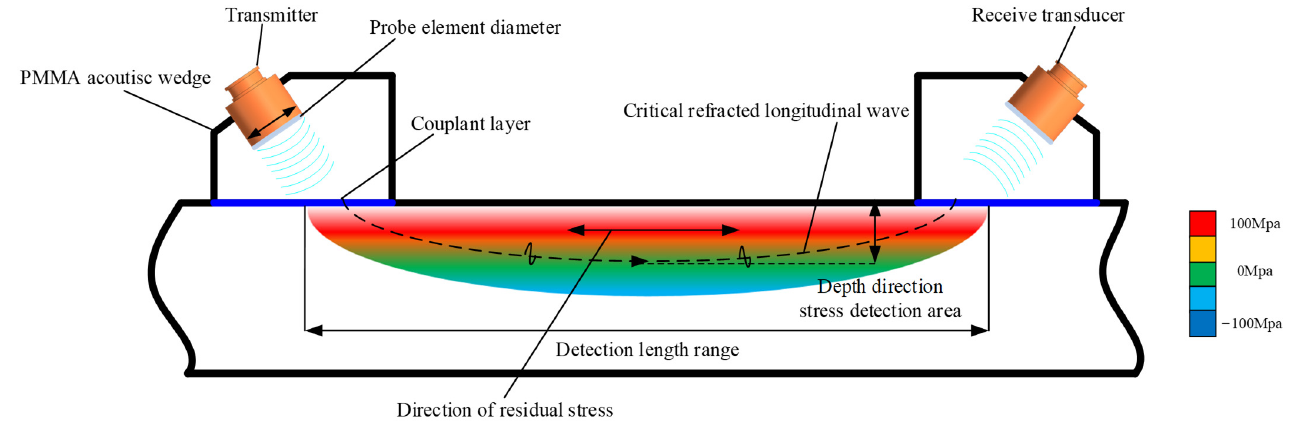
Figure 2. Diagram showing the principles of residual stress detection at different depths.